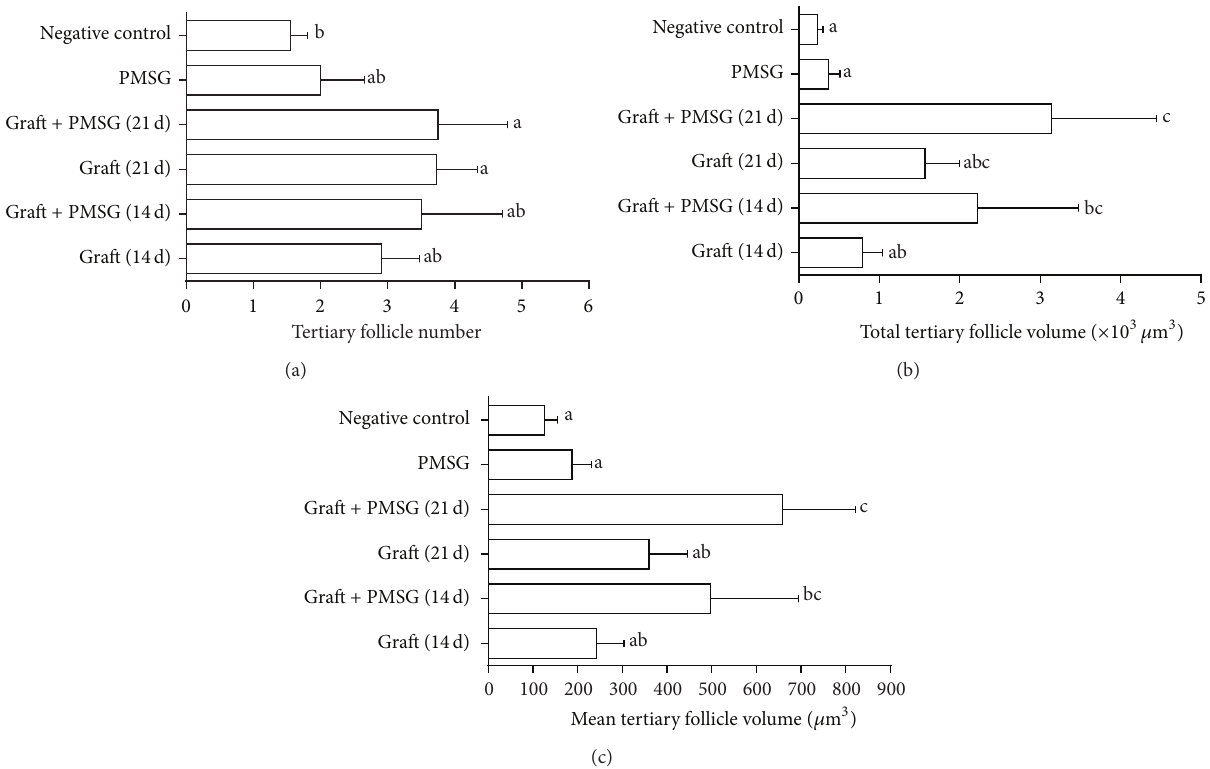
Figure 5: Mean and standard error of histomorphometric analysis of tertiary follicles (a) total number, (b) total volume, and (c) mean follicle volume in control group, pregnant mare serum gonadotropin (PMSG) group, transplantation (14 and 21 d), and PMSG/transplantation (14 and21d)groupsafterautologousovariantransplantationandsuperovulatoryeffectofPMSG. a , b , c Differentsuperscriptlettersshowsignificant difference between different groups ( 𝑃 < 0.05 ).